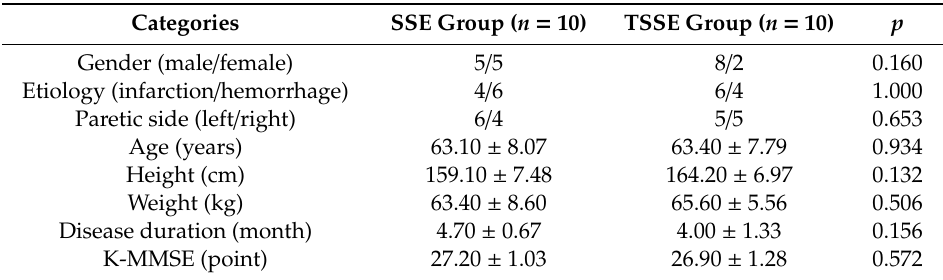
Table 1. Subject characteristics.